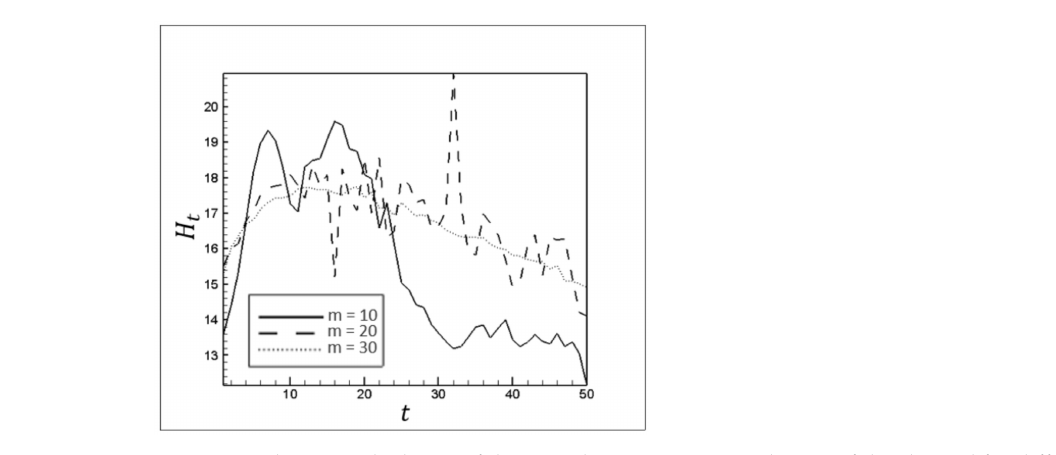
Figure 27. The mean thickness of the static layer over time at the top of the channel for different m.